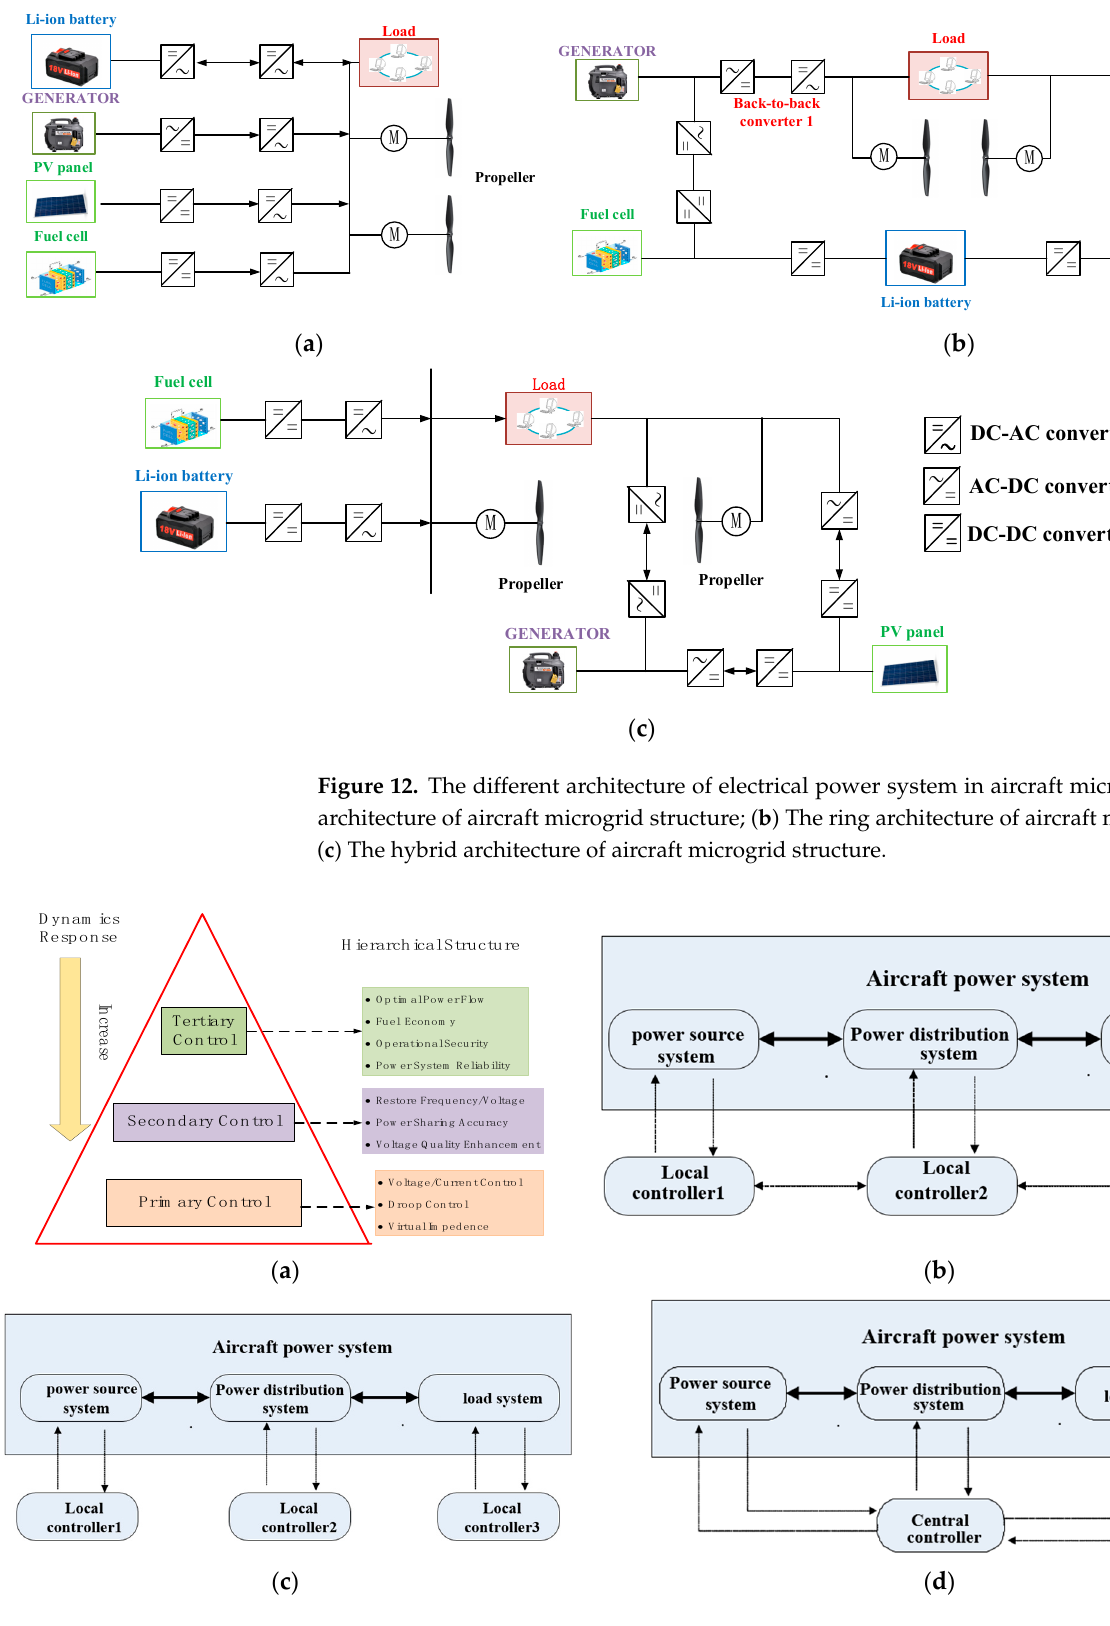
Figure 13. Different controller architecture for the aircraft power system [31]. ( a ) The hierarchical structure of control method. ( b ) The distribution controller architecture. ( c ) The decentralized controller architecture. ( d ) The centralized controller architecture